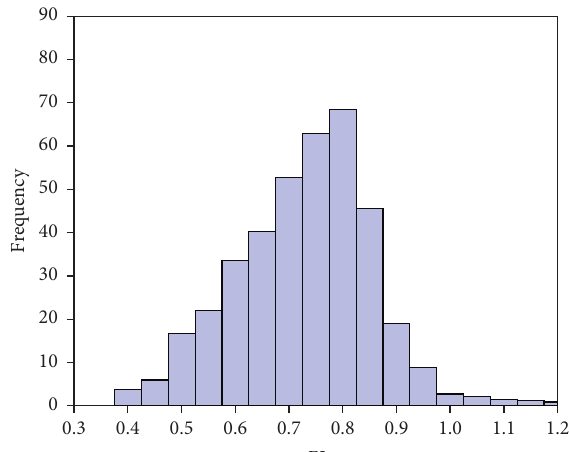
Figure 11: Statistical results of edge angles and improved posterior edge angles.